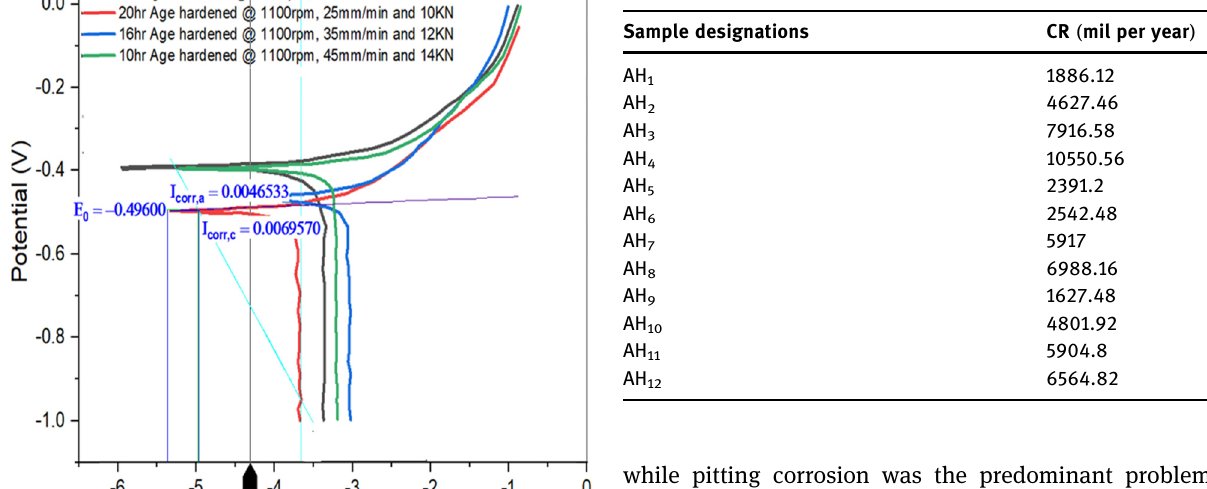
Table 5: CR of welded